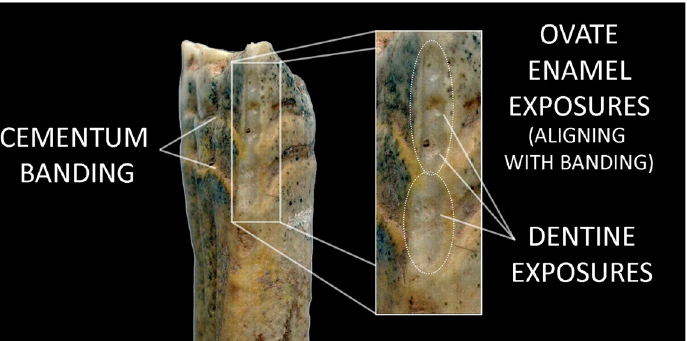
Figure 2. Botai horse tooth cited as conclusive evidence of bit wear in Outram et al. 10 , showing the existence